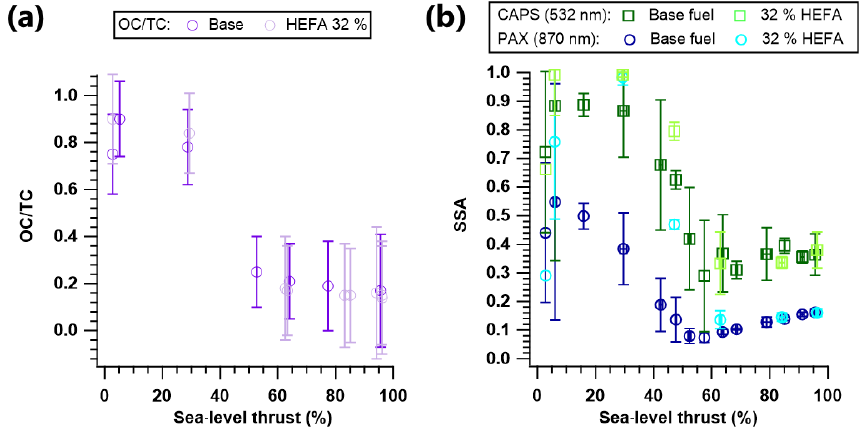
Figure 6. Thrust-dependent (a) organic carbon to total carbon fraction (OC / TC) and (b) single scattering albedo (SSA) measured at 532nm (green squares) and 870nm (blue circles). Note that dark colours represent measurements with base fuel (Jet A-1), and light colours represent measurements with the HEFA blend